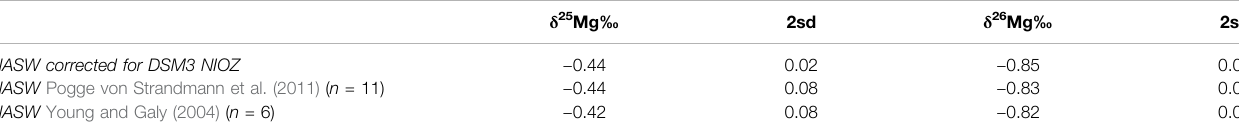
TABLE 1 | Summary of standard measurements at NIOZ.